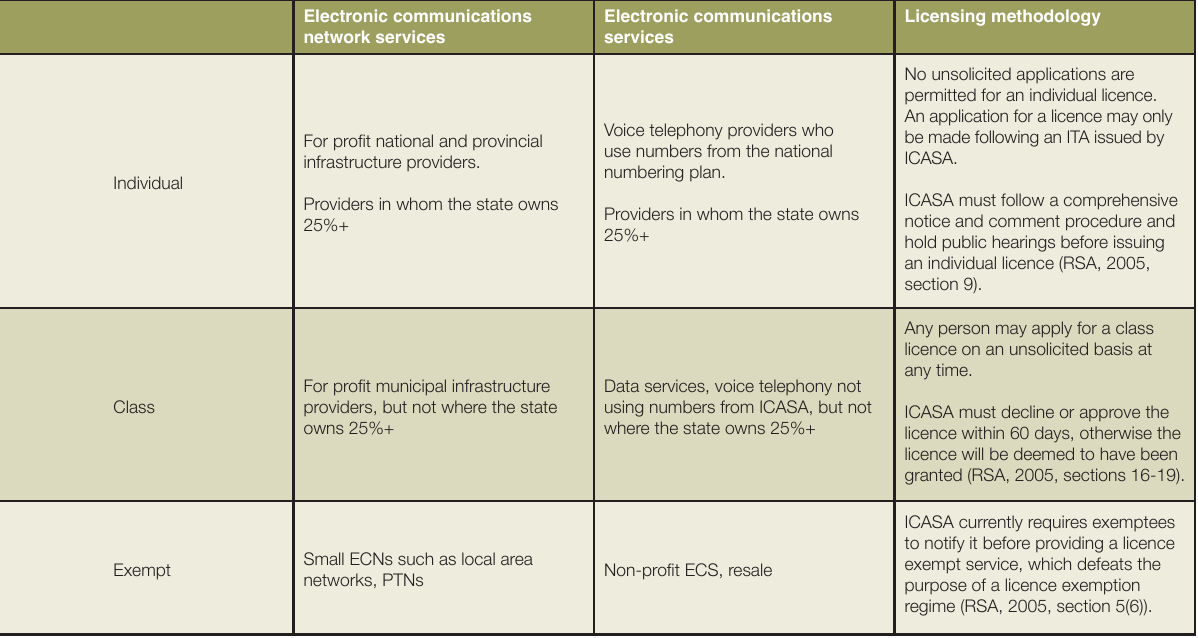
FIGURE 3: LICENCE CATEGORIES UNDER THE ECA